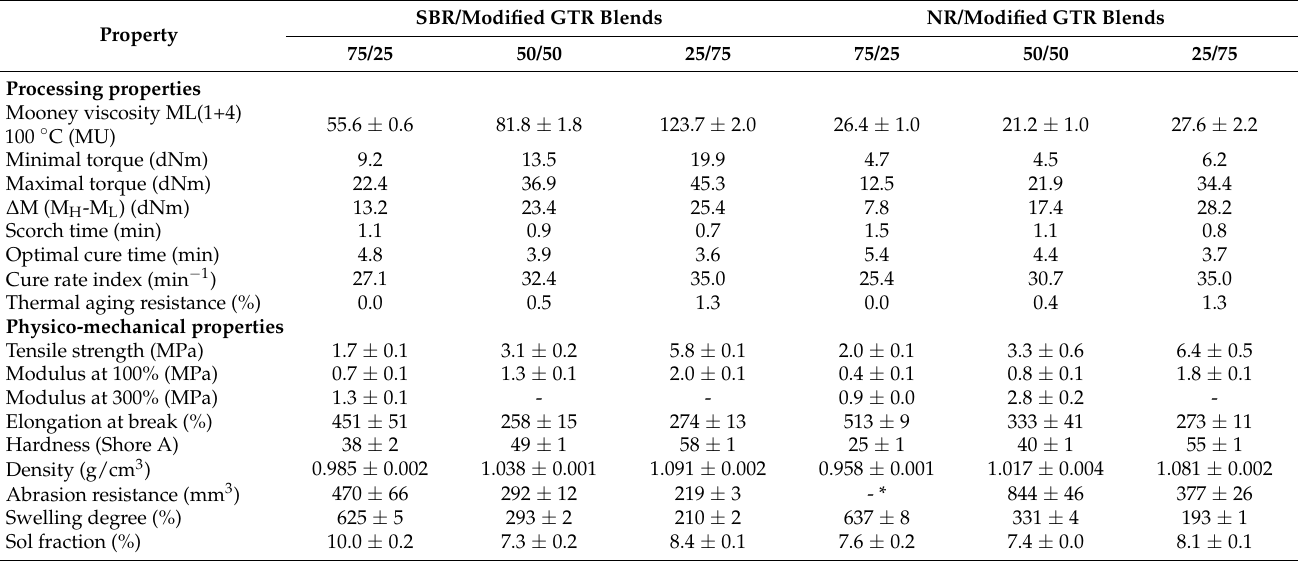
Table 8. Processing and physico-mechanical properties of rubber/modified GTR